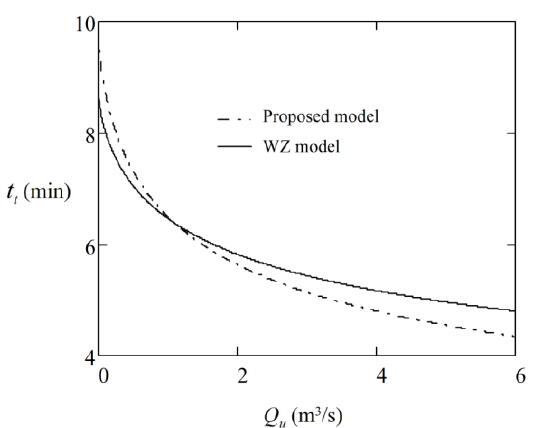
Fig. 5. Comparison of the travel time of proposed and existing methods for constant n